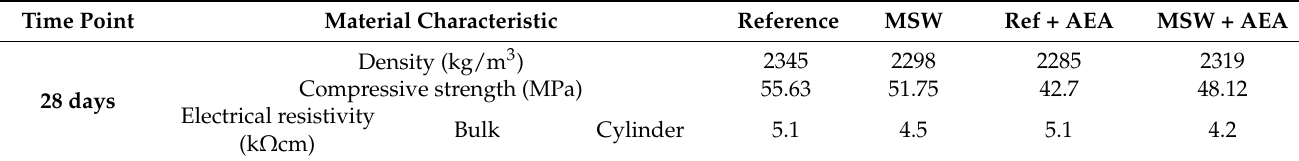
Table 3. Laboratory test results at 28 days.